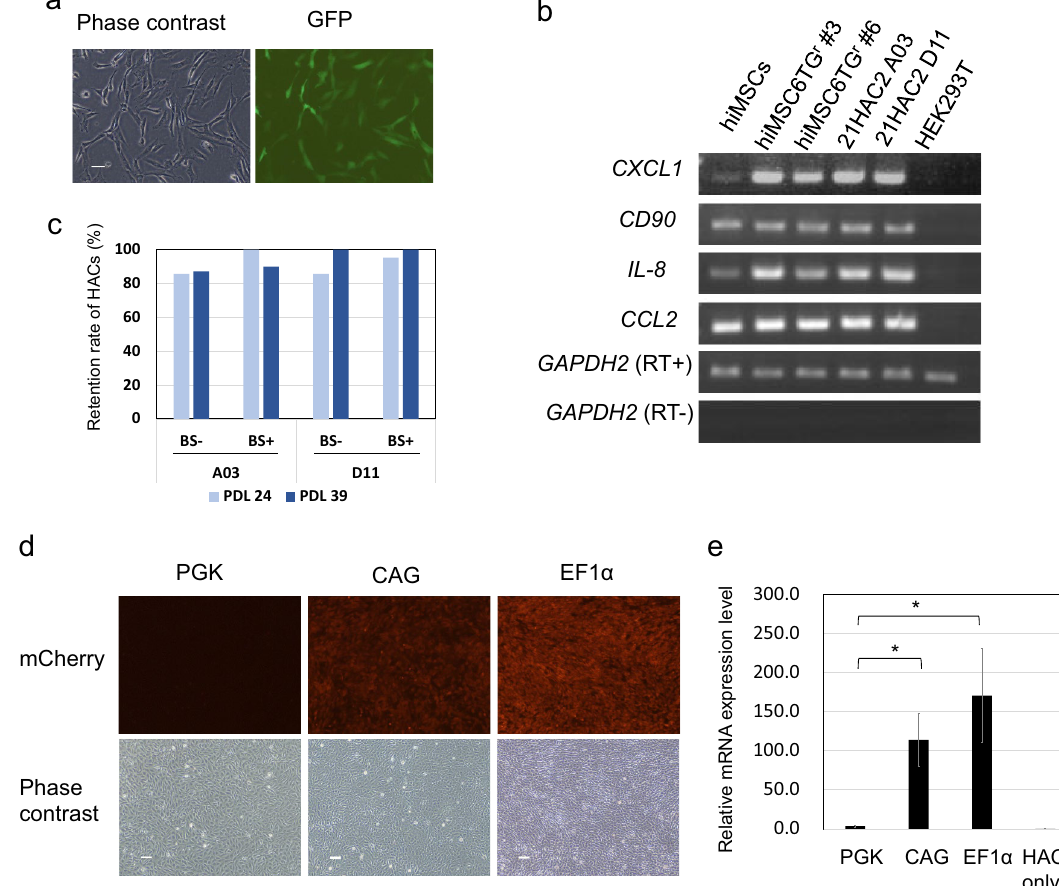
Figure 4. Characterisation of human immortalised mesenchymal stem cells (hiMSCs) that contained 21HAC2 and hiMSC/21HAC2 with the mCherry expression vector introduced by the Cre-loxP system. ( a ) Representative images of fluorescent protein expression in hiMSCs that contained 21HAC2. The left panel shows phase contrast and the right panel shows EGFP expression. Bar = 100 µm. ( b ) RT-PCR analysis of various MSC markers in hiMSCs that contained 21HAC2. The original gel images of the RT-PCR are provided in Supplementary Fig. S4. ( c ) Stability of 21HAC in each hiMSC clone (A03 and D11) after long-term cell culture with or without blasticidin S (BS). The measurement was performed at PDLs of 24 and 39. Bright blue bars show the retention ratio of 21HAC2 at PDL 24. Dark blue bars show the retention ratio at PDL 39 ( d ) Representative images of fluorescent protein expression in hiMSCs that contained 21HAC2. The left panel shows mCherry fluorescence under the control of the PGK promoter, the middle panel shows that under the control of the CAG promoter, and the right panel shows that under the control of the EF1α promoter. Bar = 200 µm. ( e ) Relative mRNA expression levels under the control of PGK, CAG, and EF1α promoters (n = 10) (* P < 0.01). P -values were calculated by the Student’s t